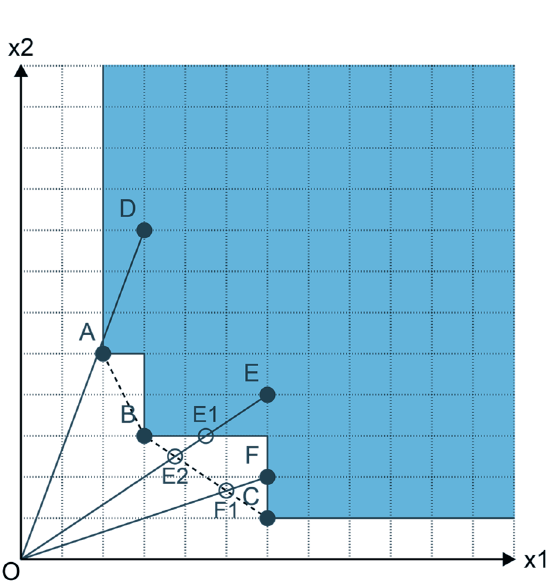
Figure 3. Free Disposal Hull (FDH) Input-Oriented Efficiency Measures.